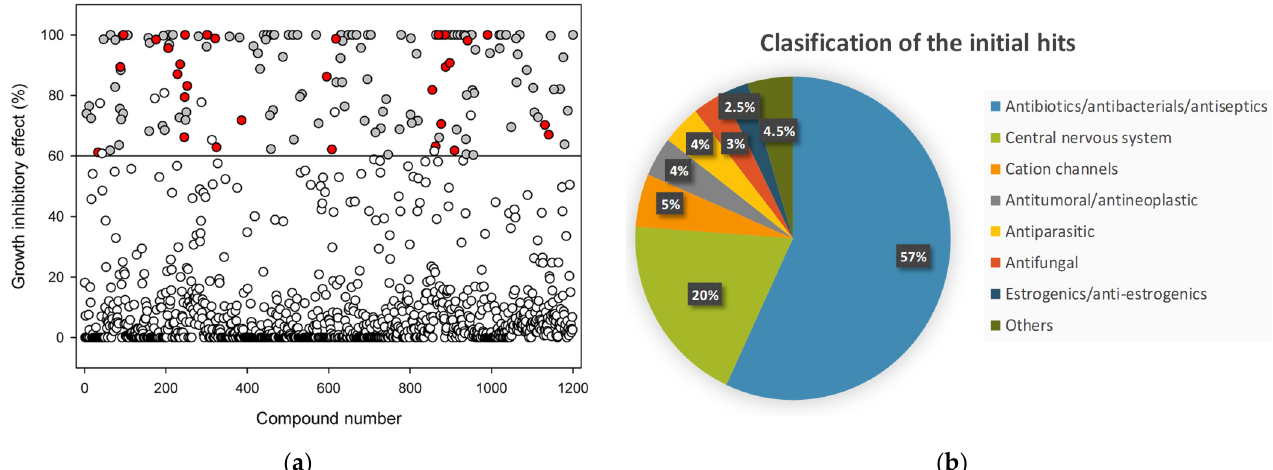
Figure 1. Results of the screening of the Prestwick Chemical Library on pneumococcal planktonic growth: ( a ) Decrease in the OD 550 of the culture induced by the presence of 50 µM of each compound after 4 h (mid-stationary phase), expressed as mean percentage of inhibitory effect relative to the 0.5% DMSO control curve. Compounds inducing a decrease in optical density higher than 60% relative to the control in the stationary phase are represented as all circles above the horizontal line (161 drugs); white circles above the line represent those compounds that could not prevent the optical density of the culture to reach more than 50% relative to the control at any other growth phase (9 drugs) and were subsequently discarded, leading to 152 initial hits (grey and red circles); among these, grey circles represent those that correspond to already described antistreptococcal drugs (121 drugs) and were also discarded for further analysis; finally, red circles represent the 31 remainder compounds that were subjected to further screening rounds; ( b ) composition of initial hits (152 compounds, red, and grey circles in panel ( a ), according to their pharmacological properties.